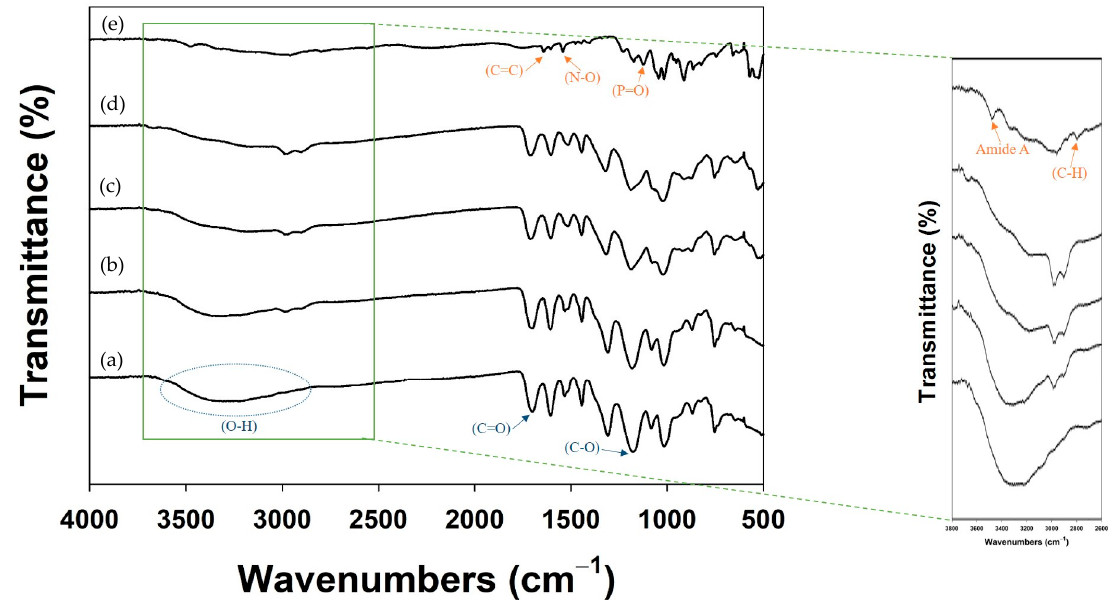
Figure 2. FT-IR spectra of ( a ) TA, ( b ) TA-ALN (1:0.1), ( c ) TA-ALN (1:0.5), ( d ) TA-ALN (1:1), and ( e ) ALN. Magnified FT-IR spectra range from 3800 to 2600 cm − 1 .